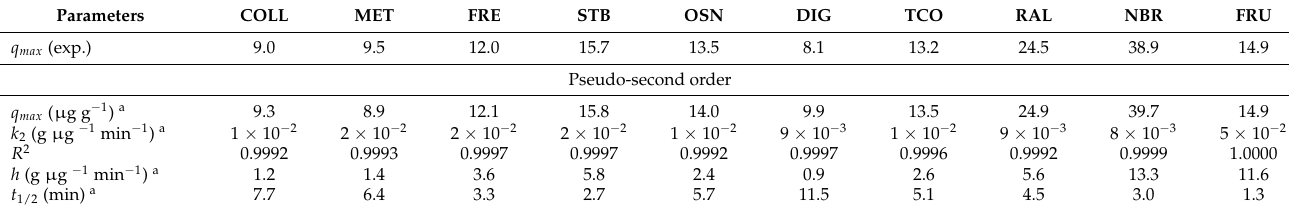
Table 5. Kinetic parameters predicted from linear analysis of pseudo-second-order model.